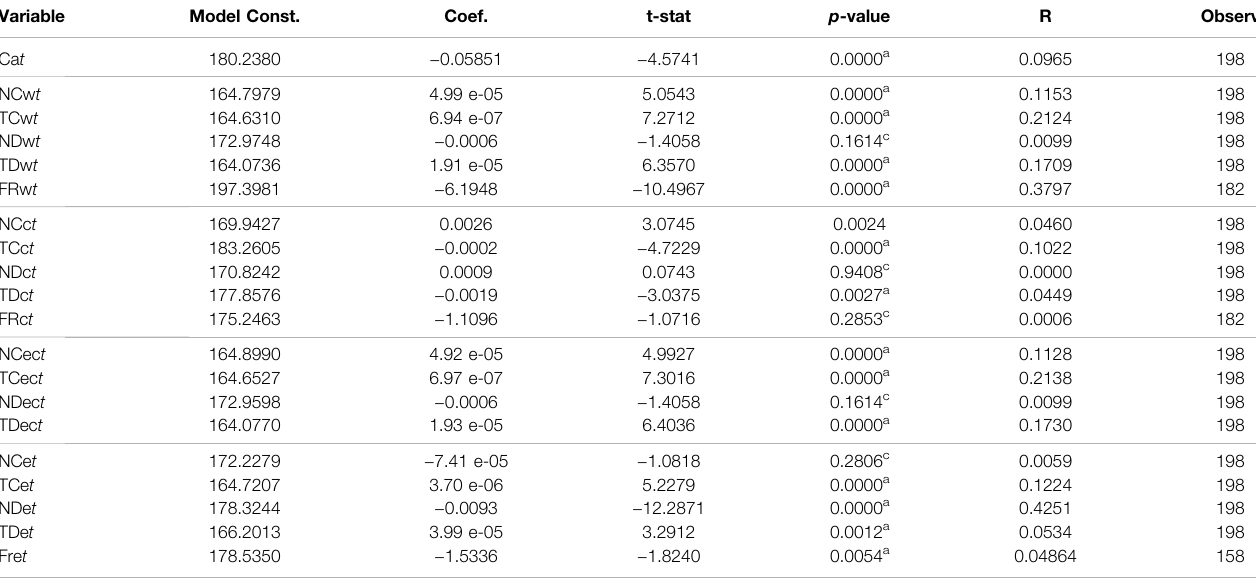
TABLE 9 | Bivariate regression models for COVID-19 effect on S&P Global LargeMidCap ESG Index. Variable Model Const.